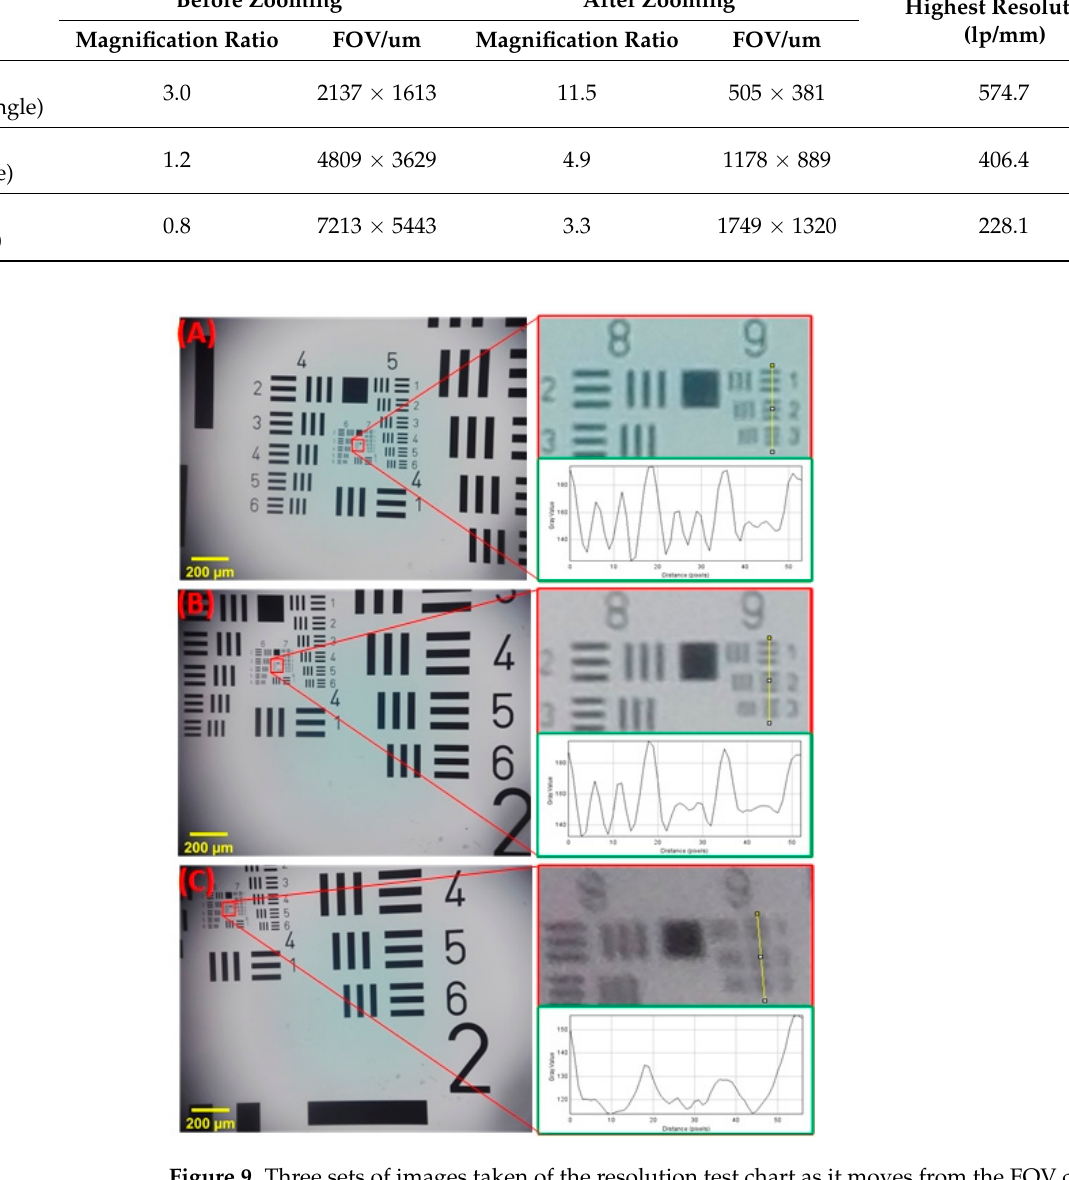
Figure 9. Three sets of images taken of the resolution test chart as it moves from the FOV center to boundary. ( A ) Lines of 575 lp/mm can be clearly distinguished when it is at the center of the FOV. ( B ) The 575 lp/mm contrast is reduced when the resolution test chart is moved outward from the center. ( C ) The 575 lp/mm features are blurred at the corner of the FOV due to vignetting and optical aperture mismatch.